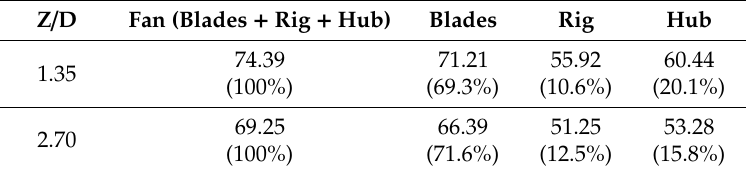
Table 2. Predicted OSPL ratio of each component to the total dipole source of the fan at Z / D = 1.35 and 2.7. Z /